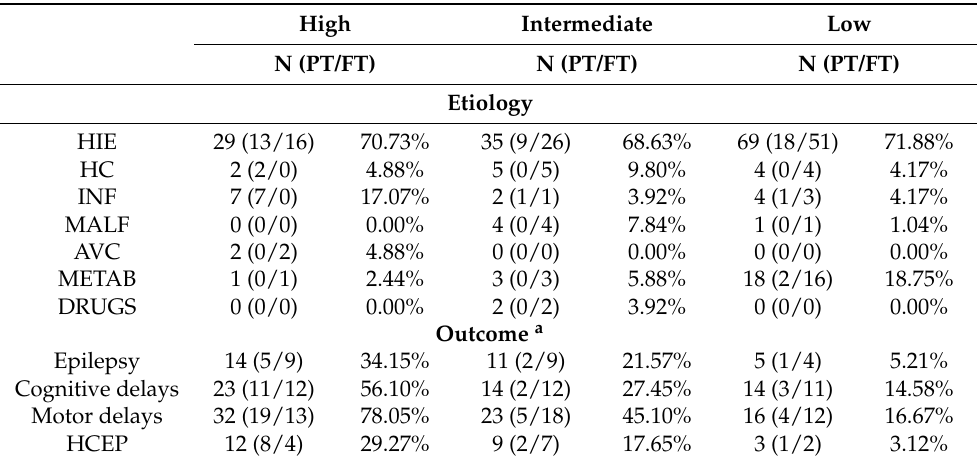
Table 5. Distribution on etiology and outcomes based on risk group categories after CART and CLUSTER output analysis. High